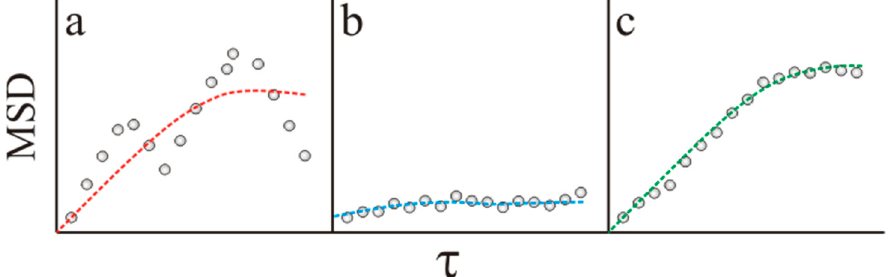
Figure 1. Three possible scenarios in the regression analysis of experimental Mean Square Dis- placement ( MSD ) vs. lag time ( τ ) data (dots) to the MSD = 4 D τ α theoretical model (dashed line). ( a ) Erratic trajectories due to uncontrollable experimental artifacts ( MSD = MSD ( τ ) ; R 2 → 0). ( b ) Nanoparticles unable to diffuse across the intestinal mucus ( MSD (cid:54) = MSD ( τ ) ; R 2 → 0). ( c ) Nanoparticles able to diffuse across the intestinal mucus ( MSD = MSD ( τ ) ; R 2 →